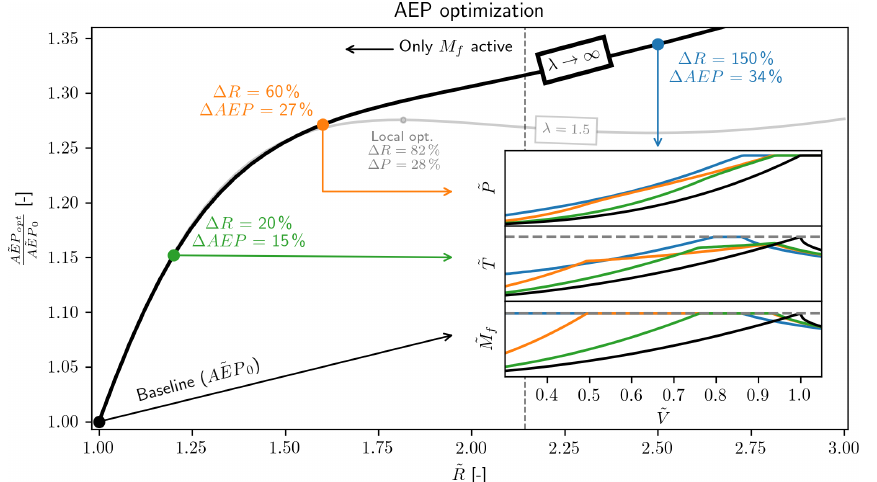
Figure 10. Optimal AEP ( ˜ AEP opt ) relative to the baseline (AEP 0 , AEP at ˜ R = 1) vs. relative radius increase ( ˜ R ). The vertical dashed line shows the point where the thrust constraint starts being active; below this line it is only the flap moment constraint that is active. The power, thrust and flap moment curves are show for four selected points, which shows how these change for increasing ˜ R . An additional line shows ˜ AEP opt with λ = 1 . 5, showing that a local optimum is formed with aerodynamic